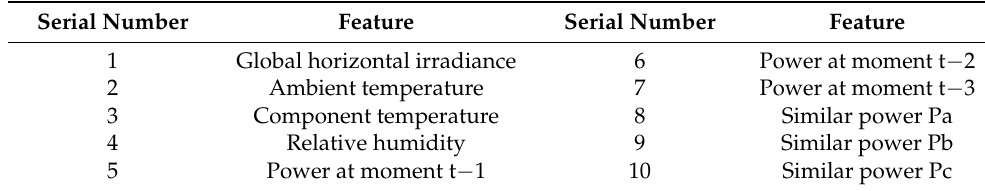
Table 4. PV output